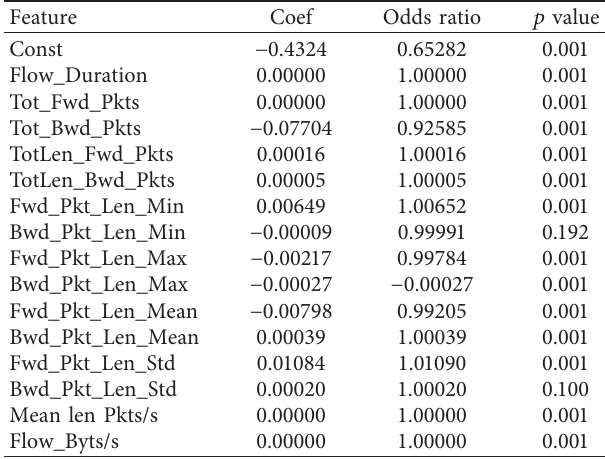
Figure 2: The variance explained by each component computed by the PCA method.